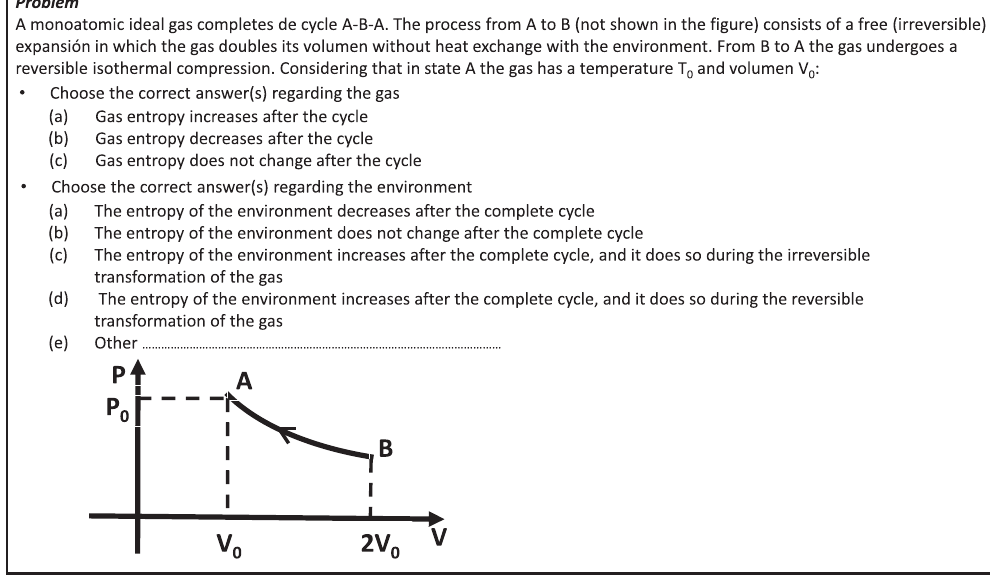
FIG. 2. Problem given to